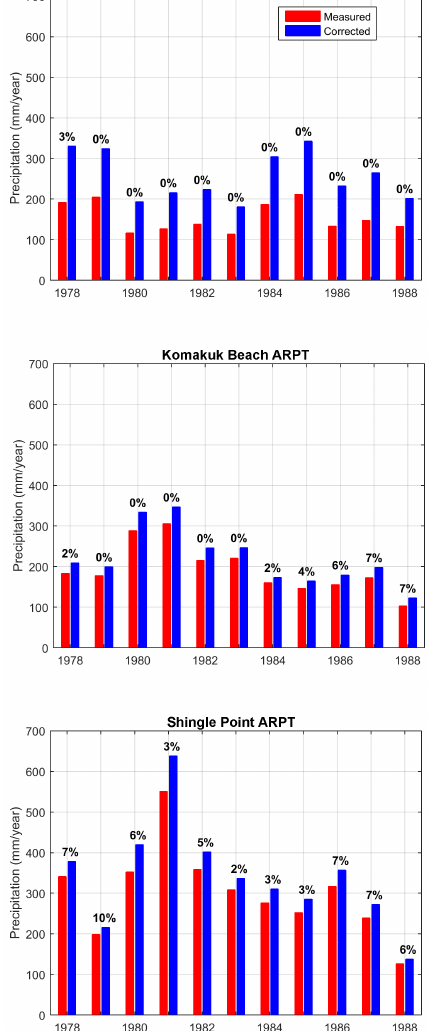
Figure 6. Annual precipitations during 1978–1988 for the three sta- tions in the northern group across the border. The percentages above the bars represent the missing data for the corresponding year.